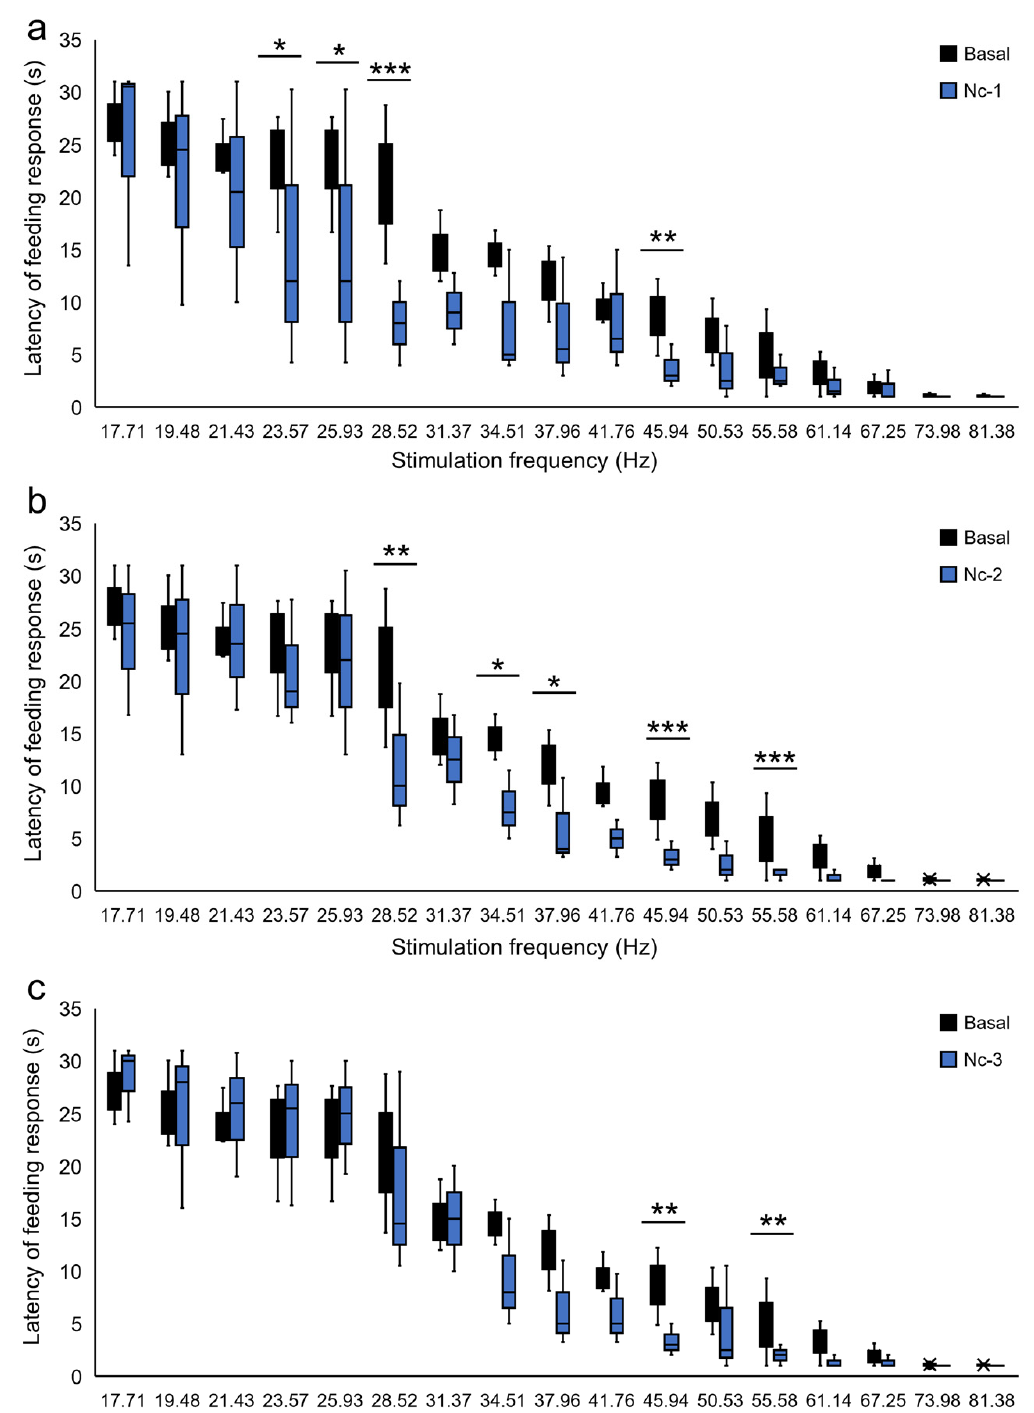
Figure 5. Destabilization of the VTA electrical stimulation (Es-VTA)-induced feeding response (FR) directly after different naloxone doses [2.5 µ g/0.5 µ L (Nc-1 group) ( a ), 5.0 µ g/0.5 µ L (Nc-2 group) ( b ), and 25.0 µ g/0.5 µ L (Nc-3 group) ( c )] injected into the PPN in the contralateral hemisphere (blue filled bars) (n = 6 for each dose) compared to artificial cerebrospinal fluid injection (ACSF; 0.5 µ L) into the PPN as basal groups (black filled bars). * p < 0.05, ** p < 0.01, and *** p < 0.001 (Tukey’s post hoc test) indicate significant differences in the FR latency at different frequencies of Es-VTA in the Nc-1, Nc-2, and Nc-3 experimental groups compared to the basal group.